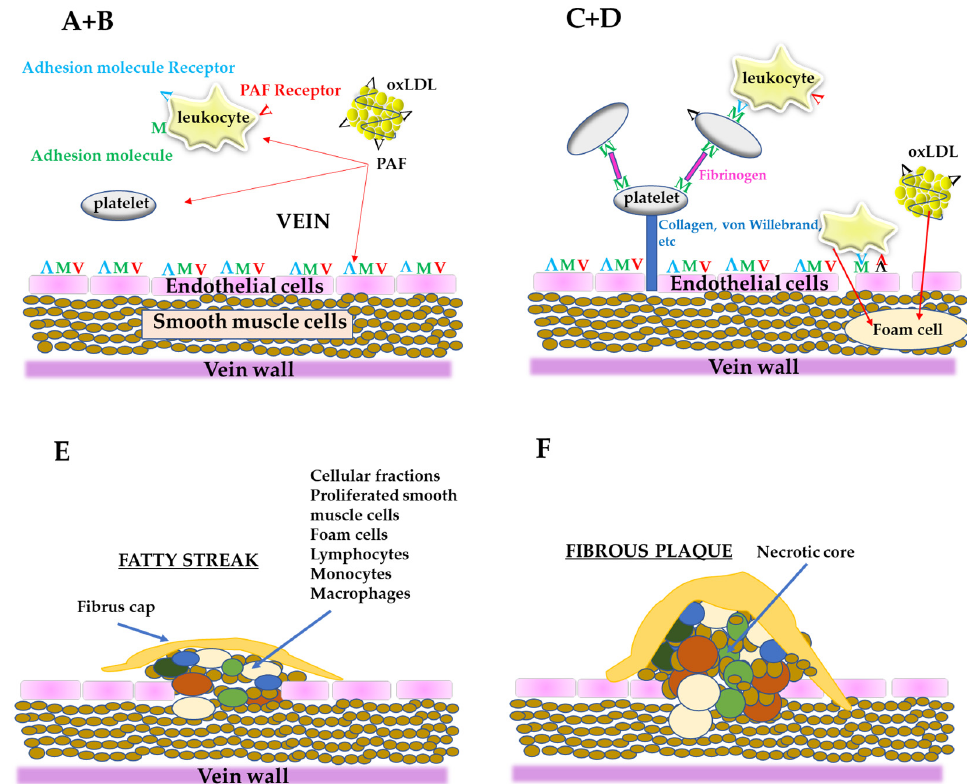
Figure 3. A simplified schematic representation of the stages of the formation of atheromatic plaque according to “the PAF implicated atherosclerosis theory”; ( A ) PAF and PAF-like activity lipids generated from oxLDL or from other sources can activate endothelial cells, leukocytes, and platelets; ( B ) Endothelium is activated (dysfunctional endothelium) along with the activation of leukocytes and platelets; ( C ) After platelet adhesion, through fibrinogen, the cells are stabilized with collagen, von Willebrand factor, etc., and make along with leukocytes a layer on the dysfunctional endothelium; Leukocytes roll along the layer of platelets-leukocytes or along the dysfunctional endothelium; When leukocytes are bound to the dysfunctional endothelium through adhesion molecules and PAF, arrest rolling; ( D ) Leukocytes move into sub endothelium space (migration) and differentiate into macrophages; Dysfunctional endothelium also permits oxLDL to migrate to the sub endothelium and is up taken by macrophages to form foam cells; ( E ) The proliferation by PAF of smooth muscle cells takes place, leading to corrupted sub endothelial architecture; The foam cells accumulate, the intimal thickness increase, and fatty steak is formed; ( F ) Within this localized lesion, continued inflammation can lead to cellular necrosis and further recruitment of monocytes and lymphocytes, with a concomitant release of different substances; This can set the stage for focal necrosis within